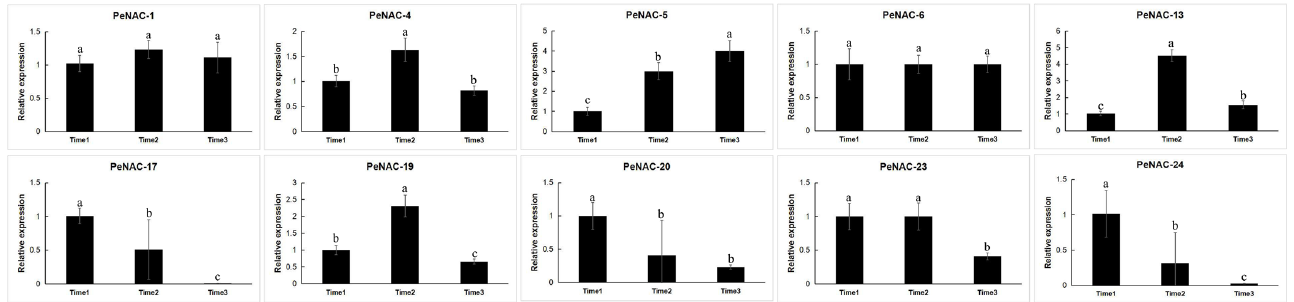
Figure 5. Expression analysis of 10 PeNACs during three fruit-ripening periods in the passion fruit. The experimental materials are identical to those used for RNA-seq during three fruit-ripening periods. The details are shown in Table S4. Data are means ± SD of n = 3 biological replicates. Means denoted by the same letter are not significantly different at p < 0.05 as determined by Duncan’s multiple range test.